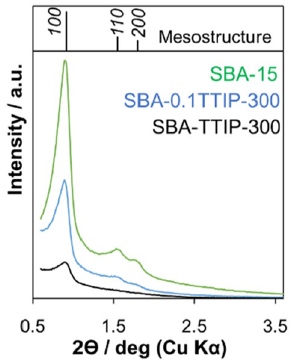
Figure 1. Low angle X-ray powder diffraction patterns of SBA-15 (green), SBA-0.1TTIP-300 (blue) and SBA- TTIP-300 (black).